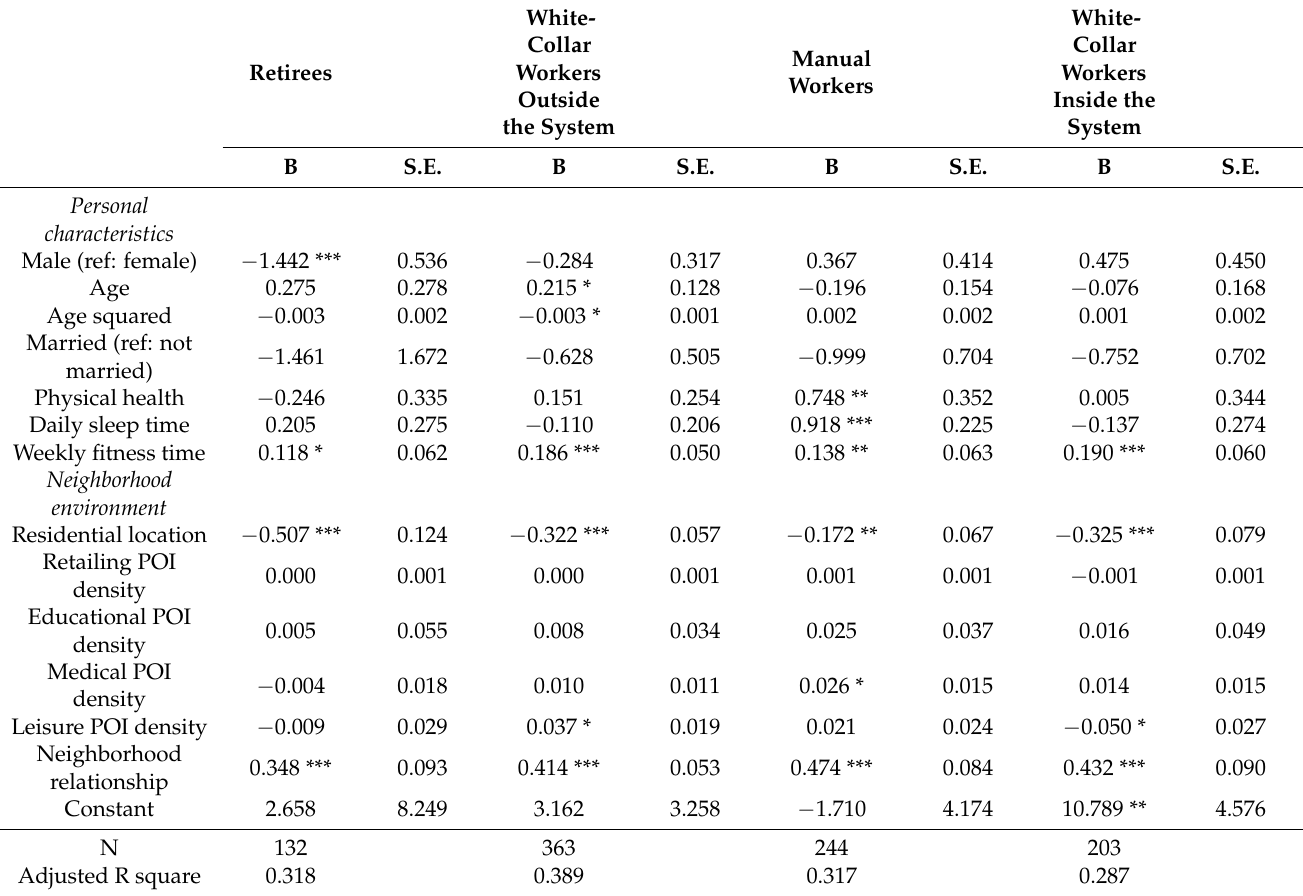
Table 3. Influencing factors of subjective well-being for different social classes. Retirees